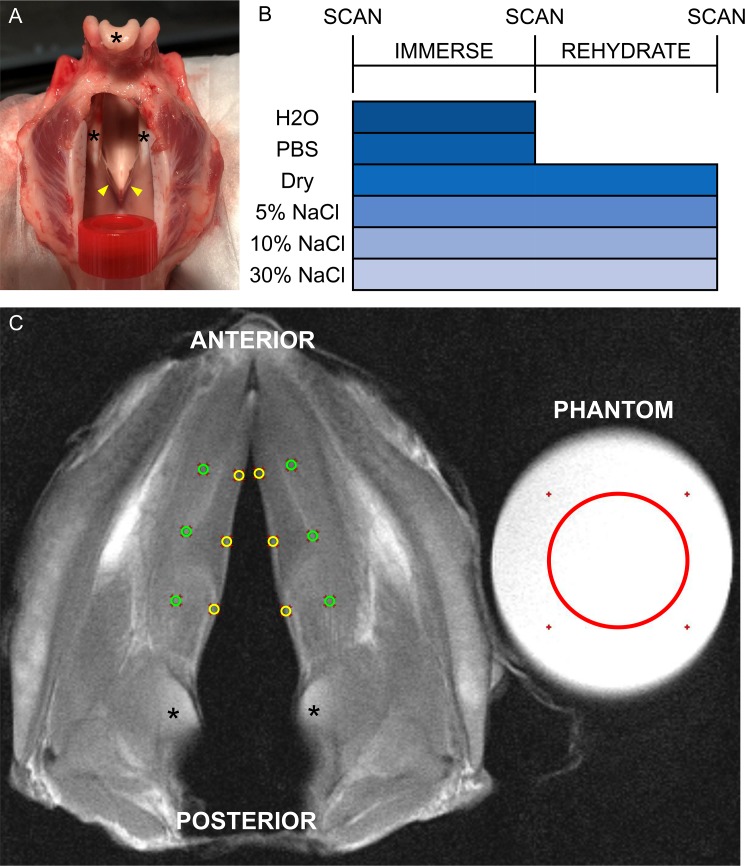
Study procedures.(A): Posterior view of porcine larynx hemisected through the posterior cricoid cartilage and held open with a 15-mL plastic centrifuge tube. Asterisk: arytenoid complex. Arrowheads: membranous vocal folds. (B): Timeline of study procedures. 30 porcine larynges, 5 per group, underwent PD-MRI scans at baseline and after immersion in water (H2O), phosphate-buffered saline (PBS), 5%, 10%, or 30% NaCl, or dry air. Larynges dehydrated in NaCl solutions or dry air were rehydrated in H2O and scanned a third time. (C): Exemplar selections for intensity measurement in a vocal fold slice. Asterisks: arytenoid complex. Yellow circles (D = 0.8–0.9 mm): intensity in anterior, middle, and posterior thirds of membranous vocal fold mucosa. Green circles (D = 0.8–0.9 mm): intensity in anterior, middle, and posterior thirds of thyroarytenoid muscle. Red circle (D = 1.5 cm): intensity of phantom.